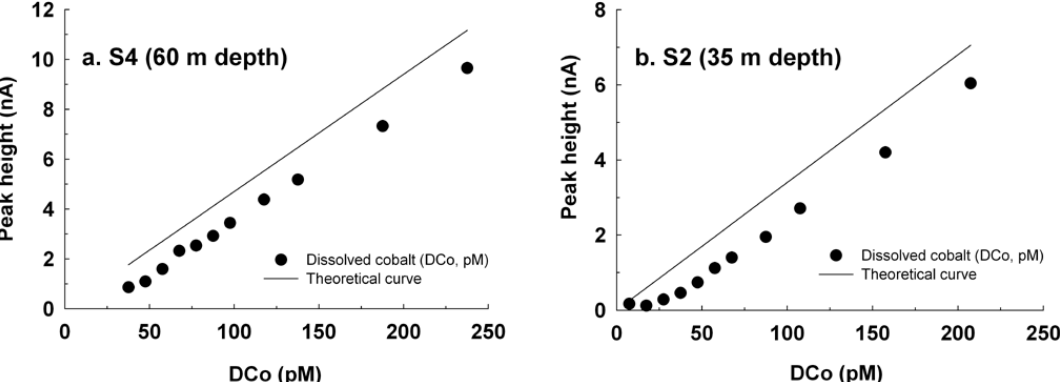
Fig. 6. Example of titration curves of the organic Co-binding ligands by standard additions of DCo (e.g.; peak height of the reduction current of Co-nioxime complexes as a function of cumulating DCo) illustrating the lack of curvature (titration a , left panel) and the curvature (titration b , right panel). The line represents the theoretical curve if no ligand was present in the sample. The lack of curvature below the theoretical curve (left panel) suggests that the organic ligands were initially saturated with Co, whereas the curvature (right panel) indicates that free Co-binding sites of organic ligands were titrated (see text for details).